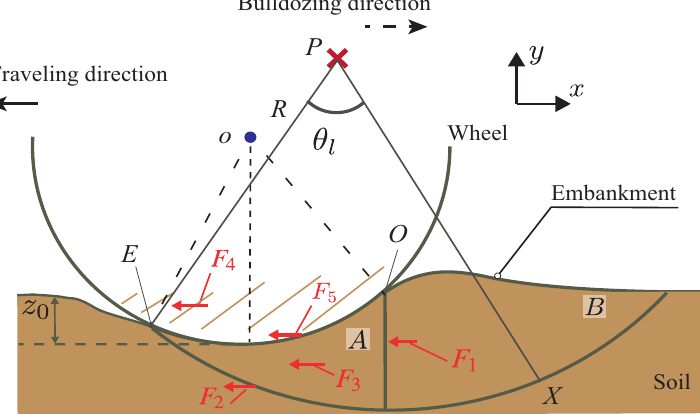
Figure 16. Schematic view of the preliminary